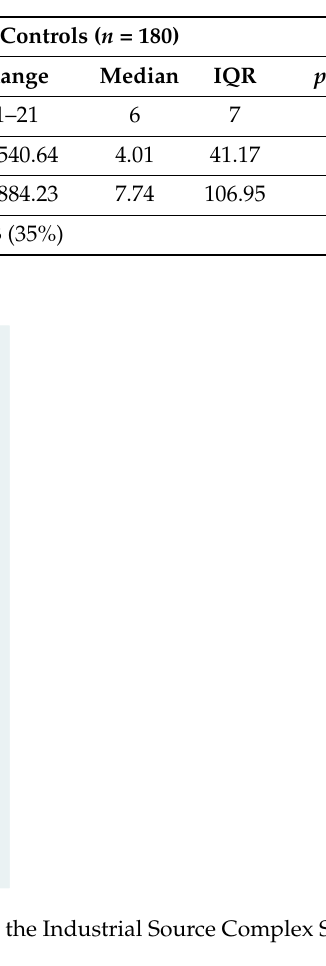
Table 3. Summary exposure metrics for sulphur dioxide exposures in the study population at the time of the sulphur stockpile fire incident.